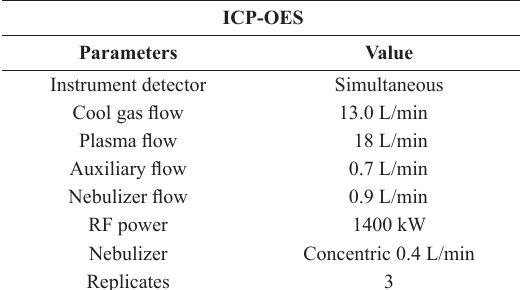
Table 1. Instrumental parameters for the determination of gold by ICP-OES.